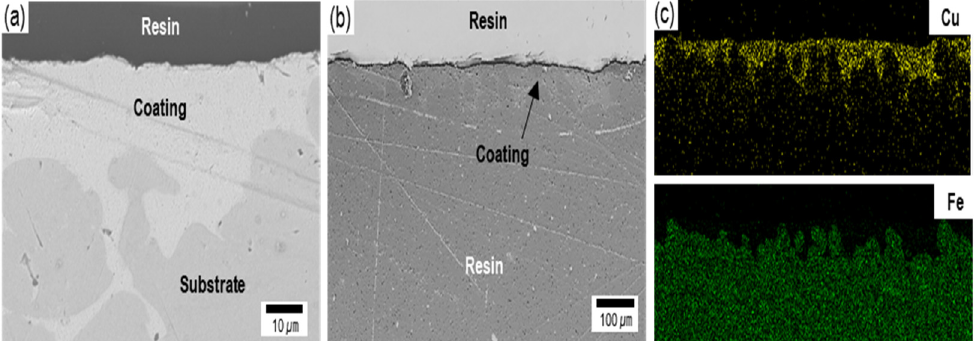
Figure 2. SEM images before ( a – d ) and after ( e , f ) copper coating. ( a ) as-received carbon steel substrate. ( b ) fine crevice structure by laser irradiation. Uncoated ( c ) all and ( d ) 48% of the substrate. Coated ( e ) all ( f ) 48% of the substrate.